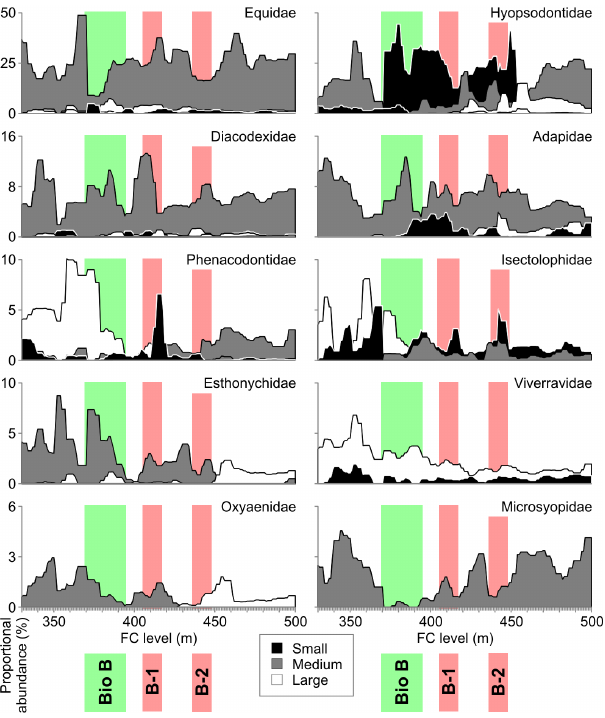
Figure 5. Changes in proportional relative abundance of species and comparative body sizes in the 10 most abundant families in the FC fossil mammal fauna. Equidae: small – Minippus index ;